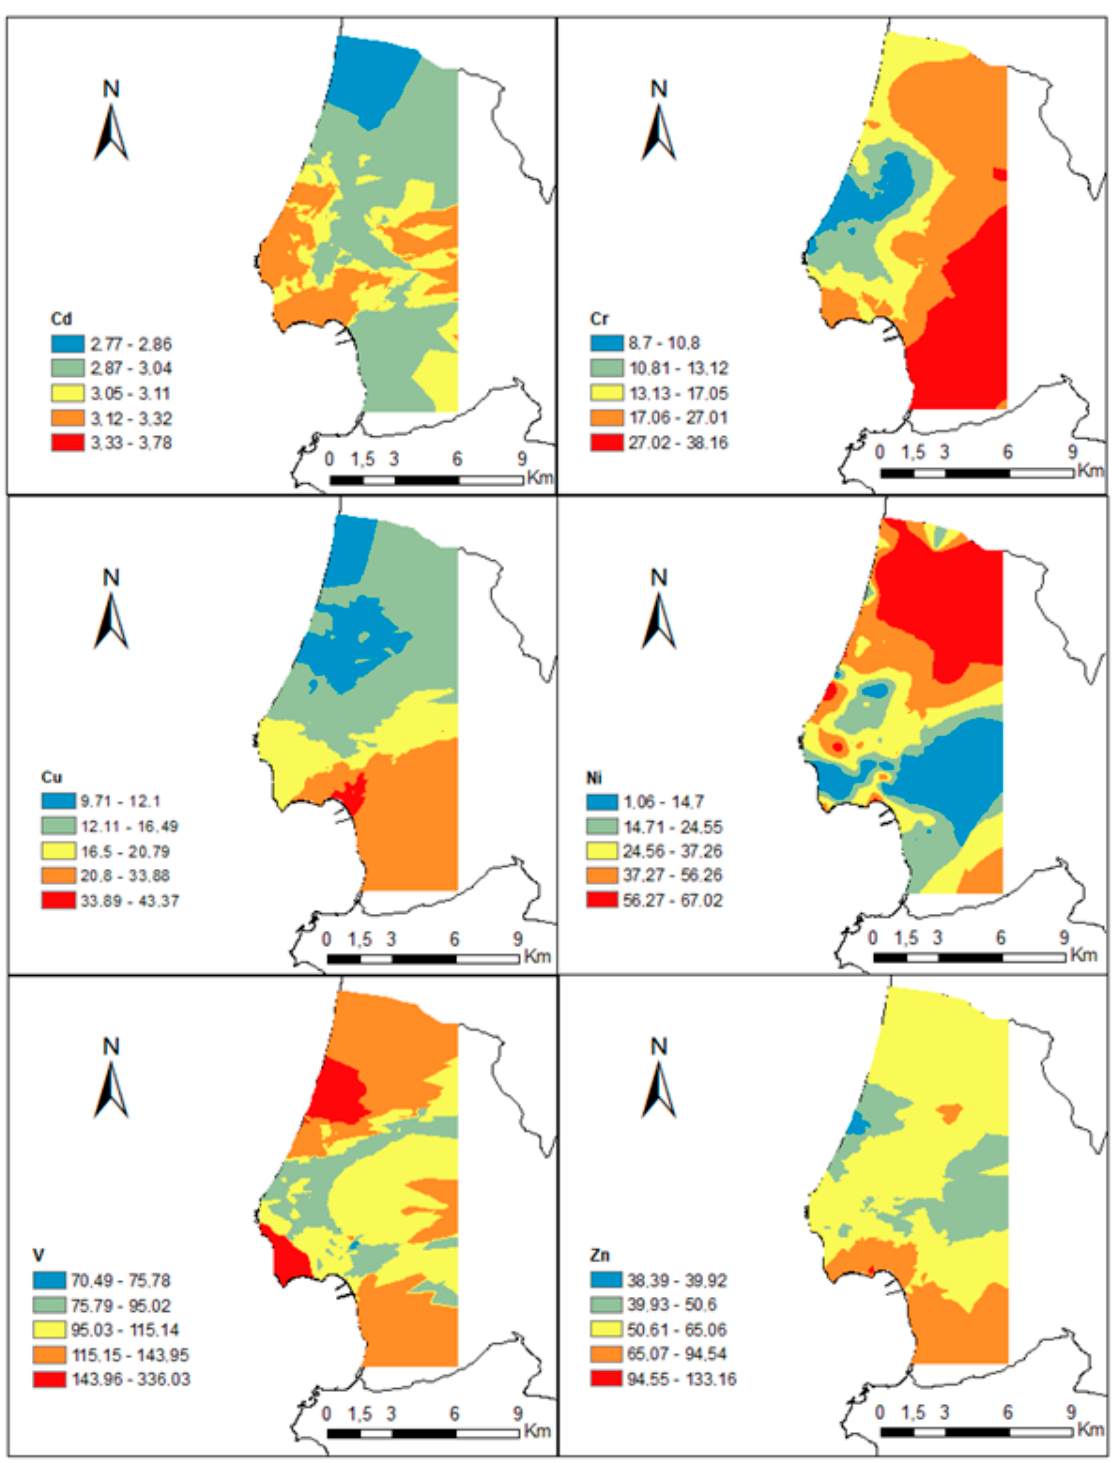
Figure 7. Spatial distribution of Cd, Cr, Cu, Ni, V, and Zn concentrations, in mg × kg − 1 . Figure 7 shows that the distribution of Cd in the area has a higher concentration in the central coastal zone of the commune, where a large number of industries are located, such as fishing, food production, mining, landfills and/or dumps, and power generation plants (Figure